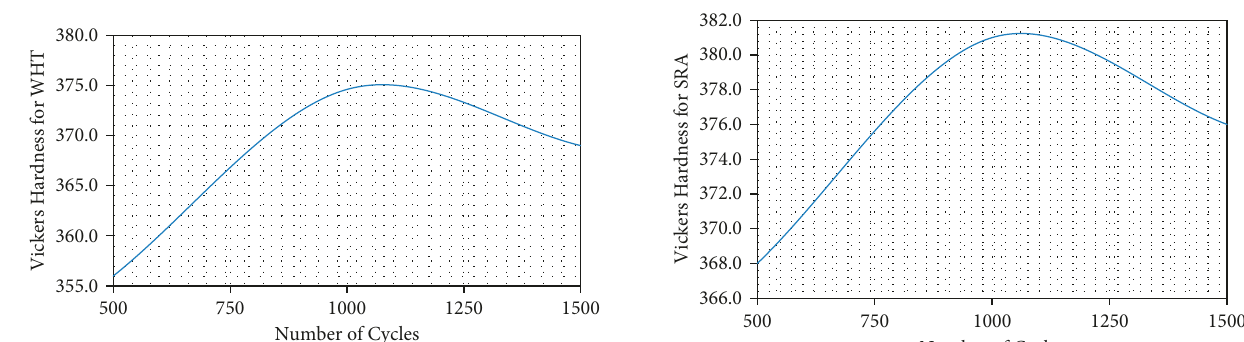
Figure 13: Vickers hardness of SRA.